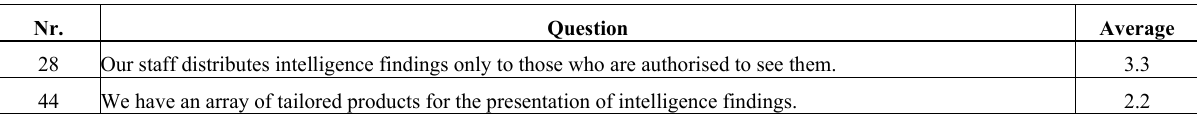
Table 12: Results of the communications questions Nr.